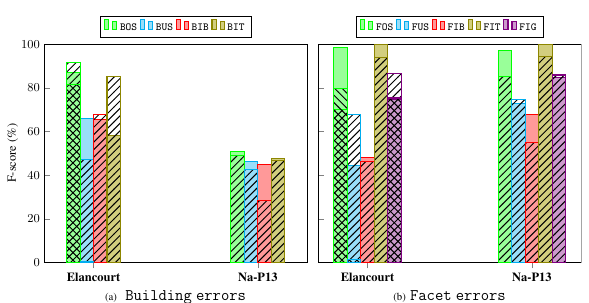
Figure 5. Vanilla F-scores obtained with a SVM using graph kernel features (colors). Hash bars: north east lines for SVM baseline and north west lines for the RMSE.